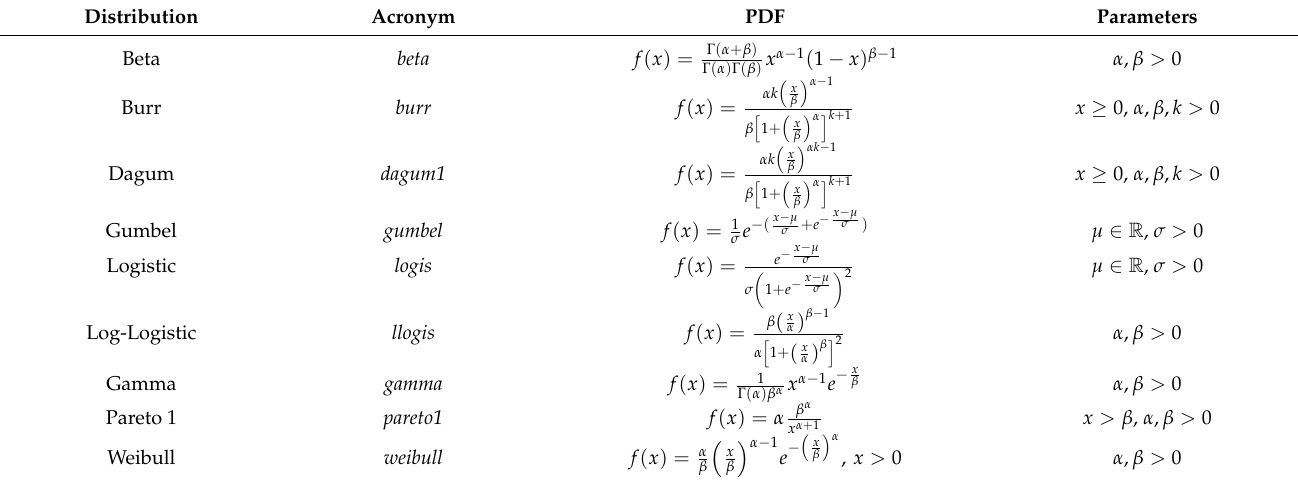
Table A1. List of the fifteen reference distributions with positive support used to test the goodness of fit for the empirical distribution of the trimmed mean gap